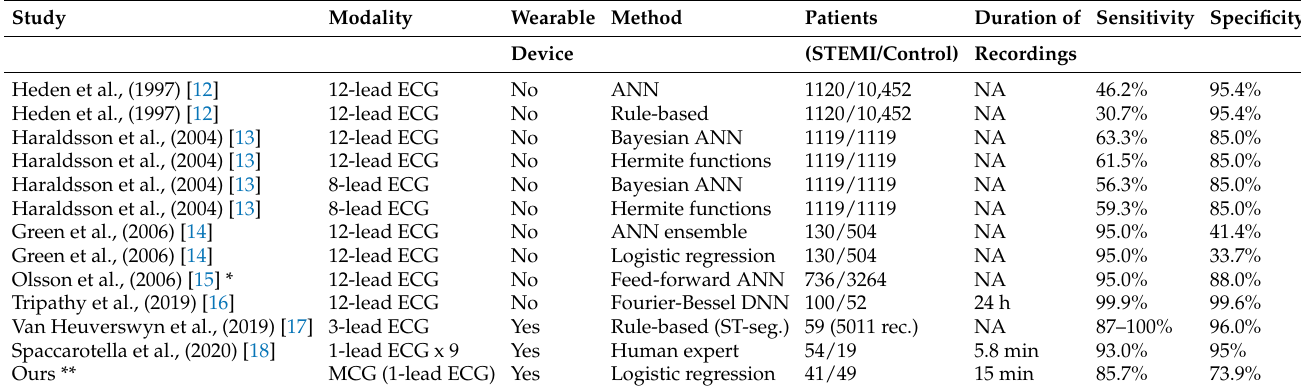
Table 2. Comparison of automated STEMI detection methods.